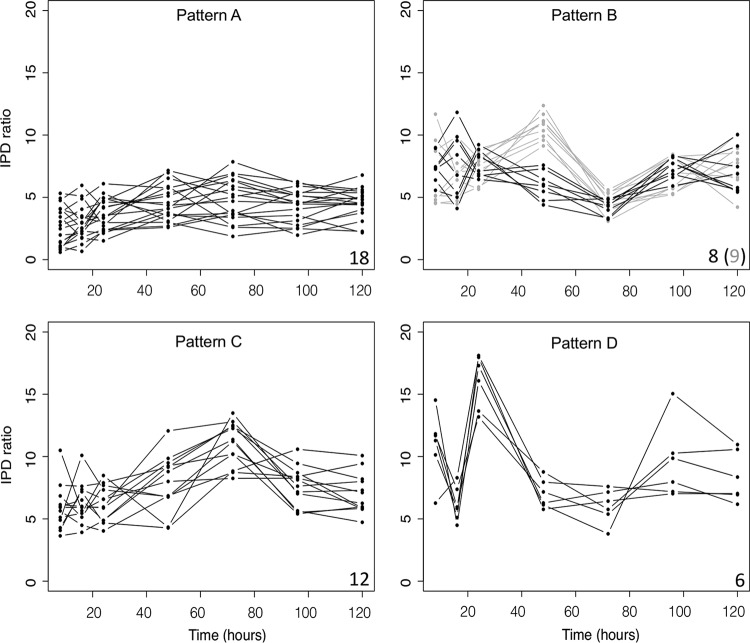
Four major patterns identified through hierarchical clustering plotted by IPD ratio over time. Pattern A contains sites where the IPD ratio is stable from 8 to 16 h and then gradually increases over time. Pattern B contains sites where the IPD ratio generally declines from 24 to 72 h (with a subpopulation that increases at 48 h) and then increases up to 120 h. Pattern C contains sites where IPD ratios reach the highest value at 72 h and then decrease. Pattern D sites have the highest IPD ratios at 24 h with a subsequent increase after 72 h. Numbers in the bottom right-hand corner in each panel indicate the number of sites with each pattern (grey number in parentheses represents the grey subpopulation in pattern B).